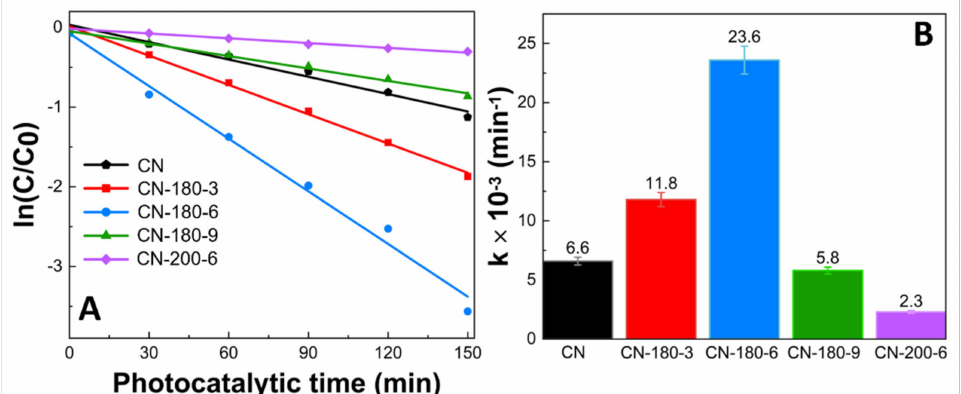
Figure 7. ( A ) The pseudo-first-order reaction kinetics and ( B ) rate constants (k) of as-prepared photocatalysts for TC photodegradation.